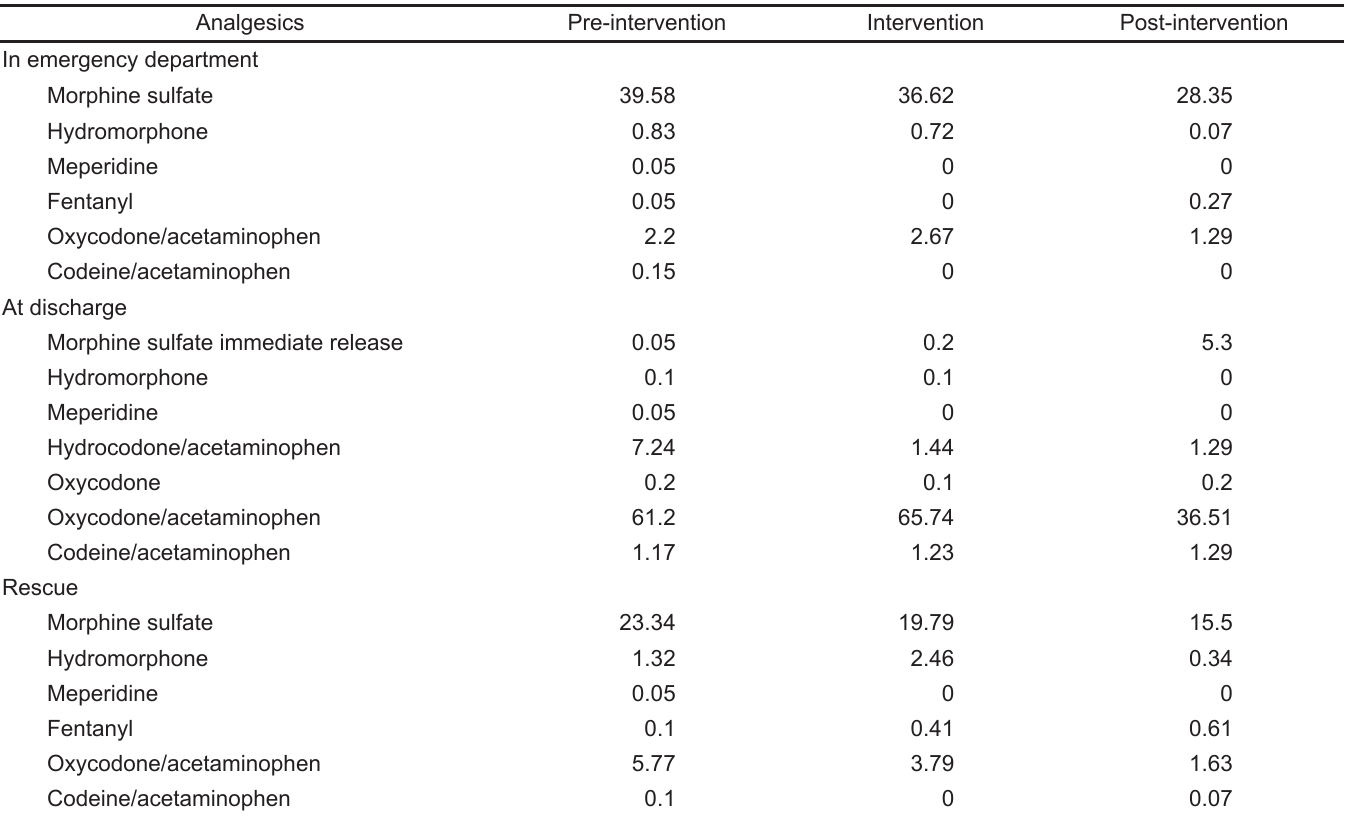
Table 2. Percentages of patients receiving individual opioid analgesics.